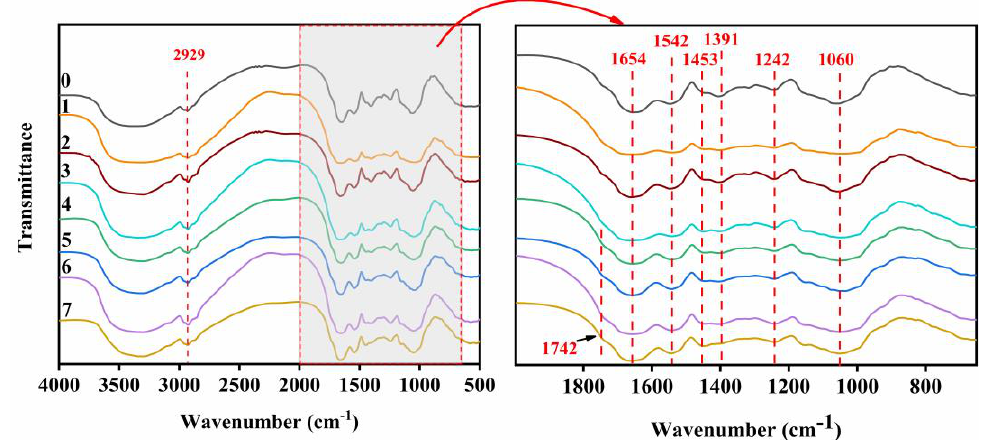
Figure 1. Attenuated total reflection FTIR spectroscopic results from the cured adhesive samples: (0) HPM adhesive, (1) HPM-papain adhesive, (2) HPM-sodium dodecyl sulfate (SDS) adhesive, (3) HPM-urea adhesive, (4) HPM-PAE adhesive, (5) HPM-papain-PAE adhesive, (6) HPM-SDS-PAE adhesive, (7) HPM-urea PAE adhesive.